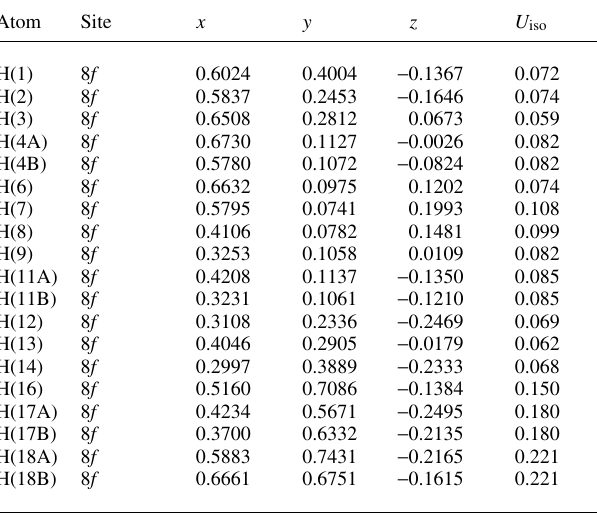
Table 2. Atomic coordinates and displacement parameters (in Å 2 )